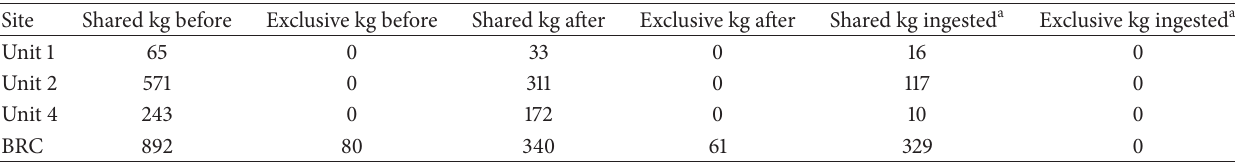
Table 1: Amount of total and exclusive tuber resources and the amount of tuber biomass ingested for each wetland between September and March. Exclusive resources are only available to trumpeter swans. All values reported as 10 3 .